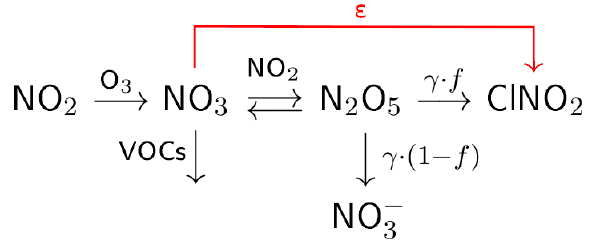
Figure 1. Simplified scheme of chemical reactions and parameters involved in the formation of ClNO 2 . The ClNO 2 production effi- ciency per NO 3 formed is denoted as ε . The uptake coefficient to the particle phase is represented by γ and the ClNO 2 yield (per N 2 O 5 taken up) by f